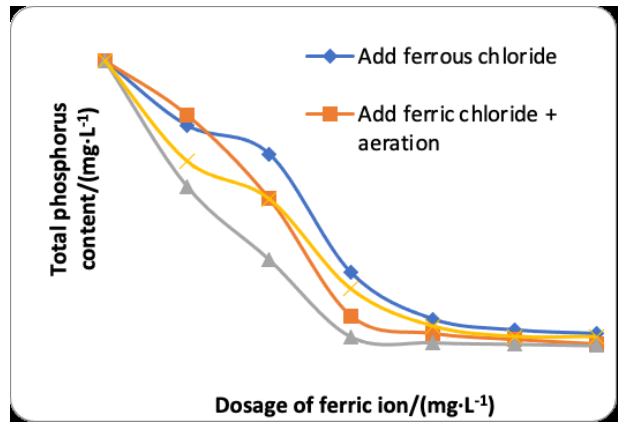
Fig. 3 Effect of adding ferric salt on phosphorus